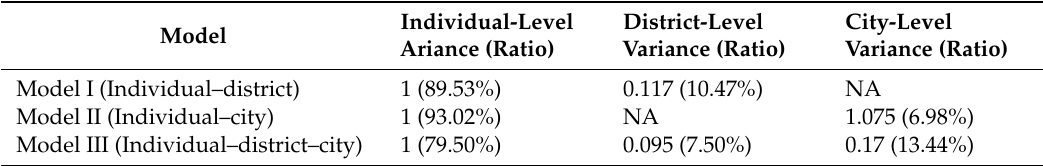
Table 2. Variance component estimates model of FPHEB’s PUPS.